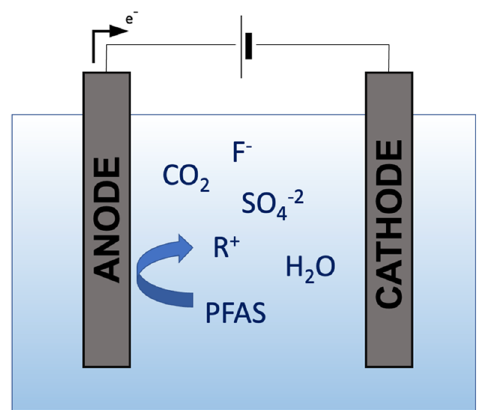
Figure 2. Mechanism of Electrochemical Oxidation.